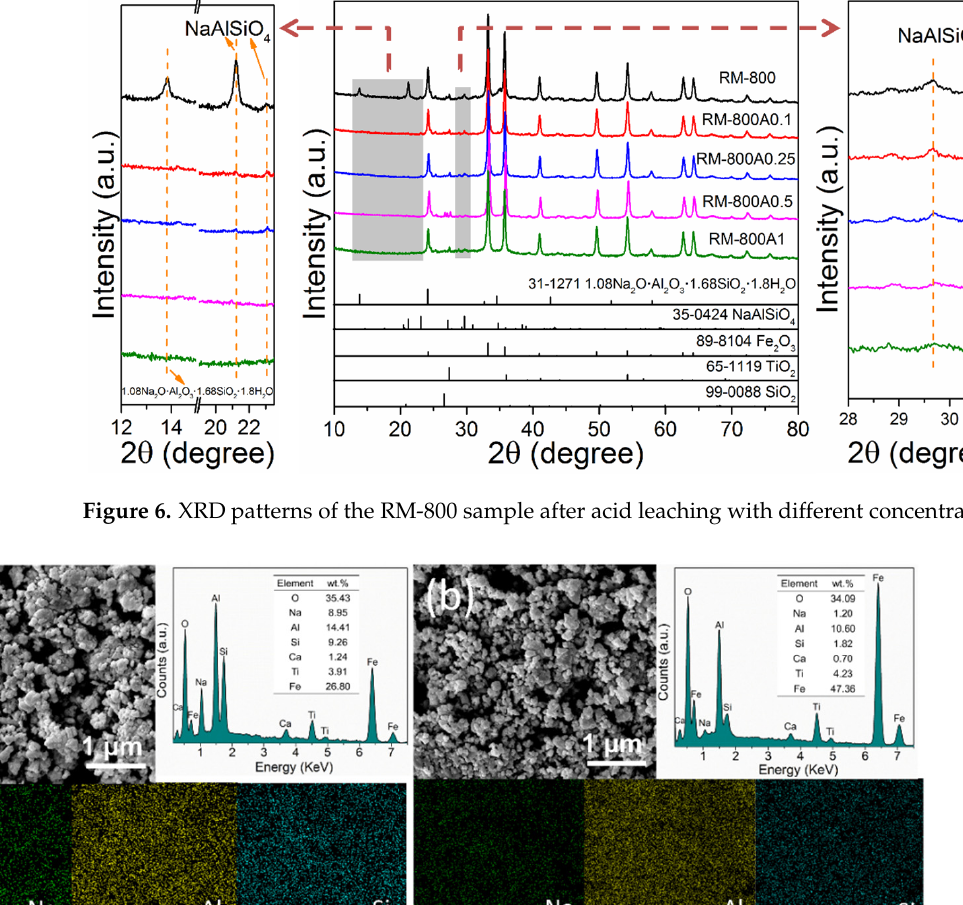
Figure 6. XRD patterns of the RM-800 sample after acid leaching with different concentrations. Table 2. The pH of leachate and the relevant weight loss of leached red mud samples.